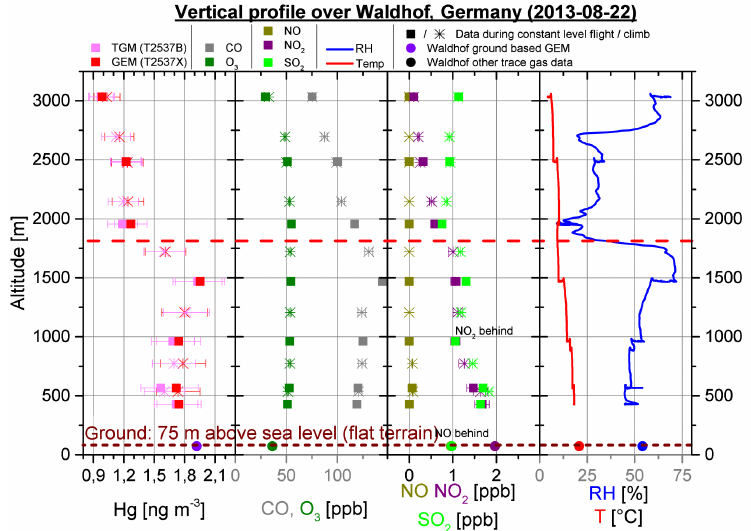
Figure 6. Same as Fig. 3, but over the GMOS master site Waldhof, Germany (52.801 ◦ N, 10.756 ◦ E, elevation: 75m, flat terrain). The profile was measured on 22 August 2013 from 10:22:30 to 11:17:30 (local time). The PBL top (red dashed line) was determined to be at 1750 to 1850ma.s.l. Additionally the data measured at the same time at the ground-based site Waldhof are plotted. TGM and GEM concentrations are given at standard temperature and pressure ( T = 273.15K, p = 1013.25hPa).